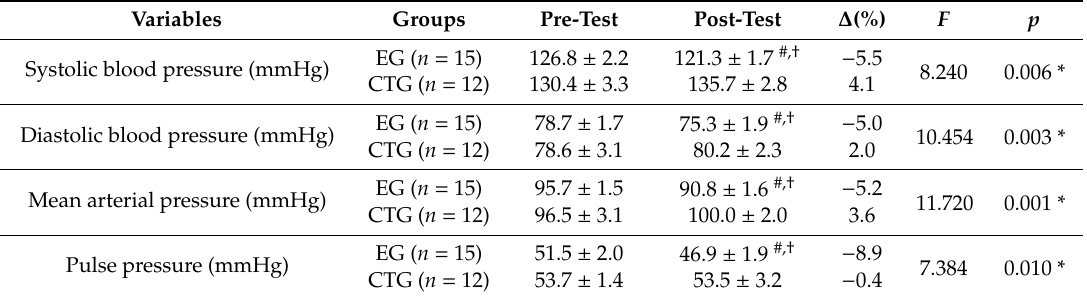
Table 2. Changes of blood pressure responses between exercise and control group in EBE program.